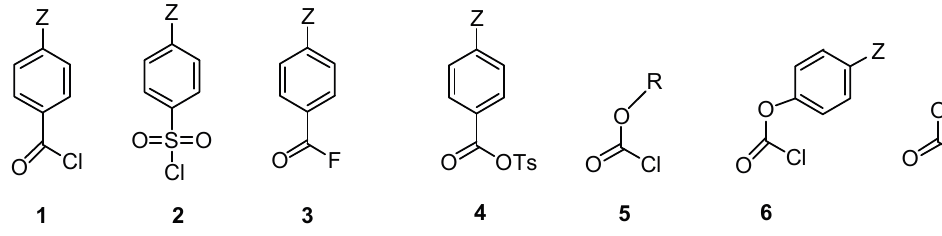
Figure 2. The substrates ( 1 – 7 ) are: named as follows: ( 1 ) p -Z-substituted benzoyl